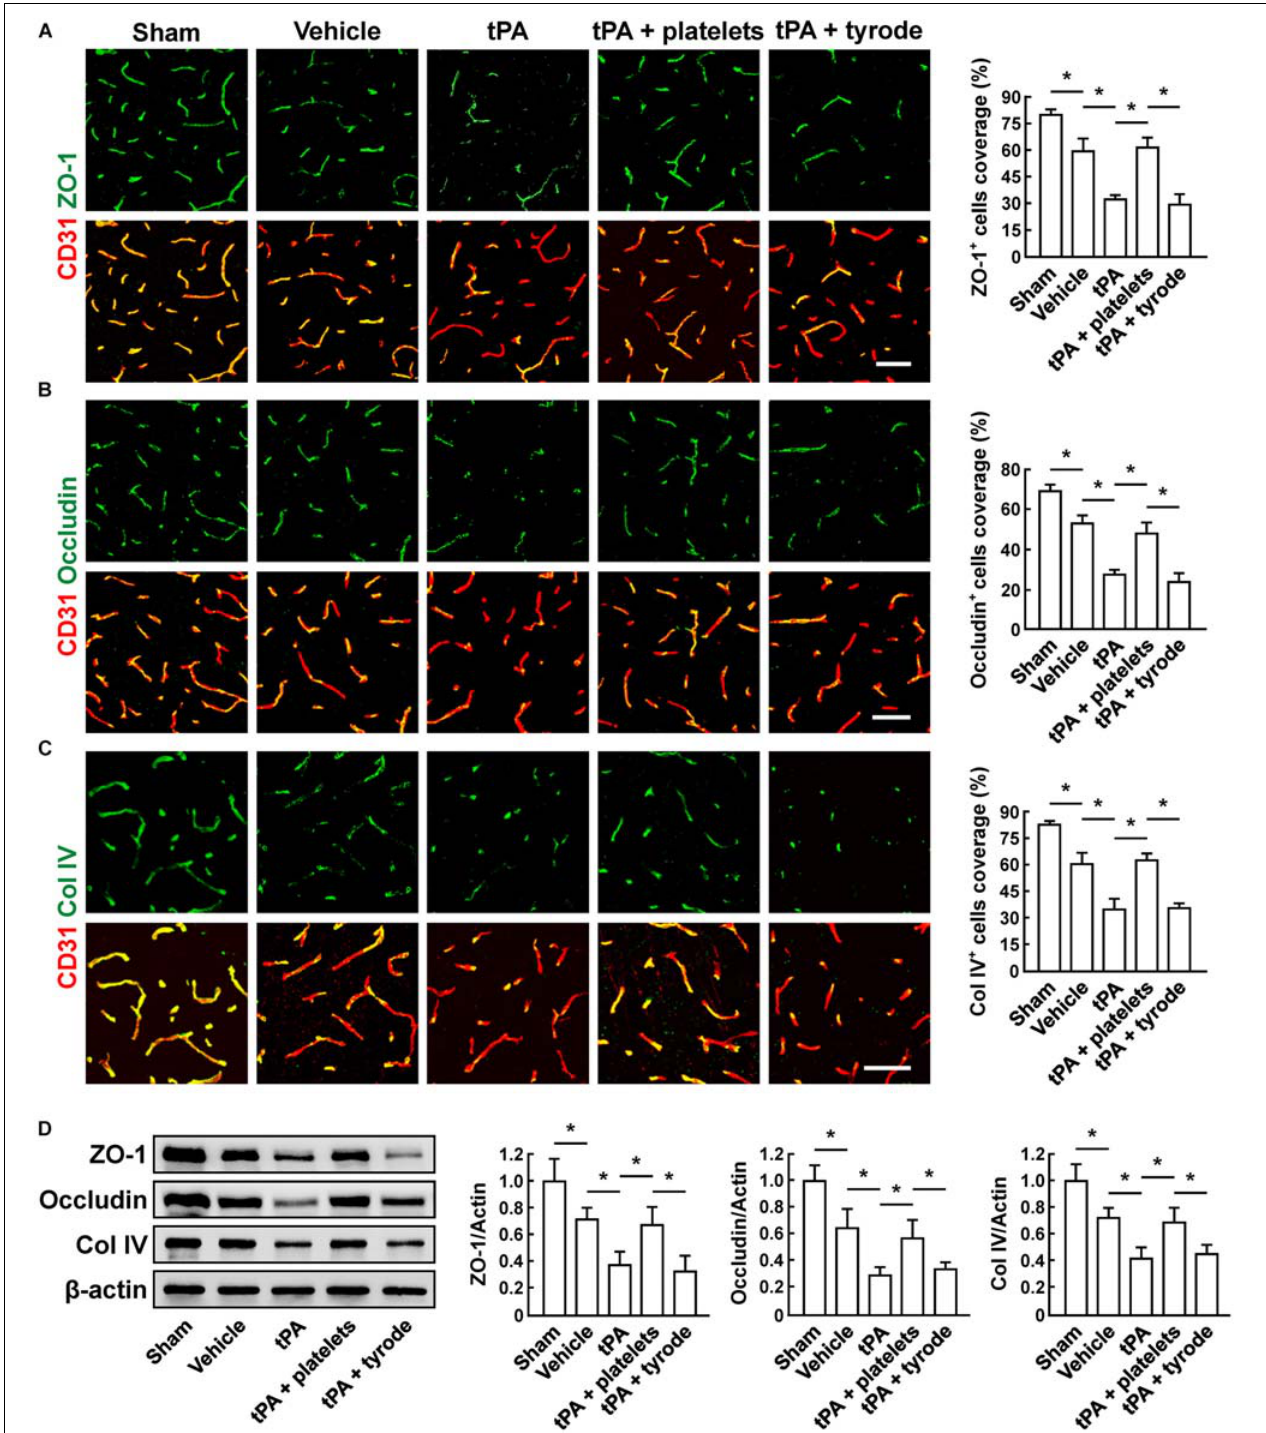
FIGURE 3 | Transfusion of resting platelets ameliorated tPA-induced loss of cerebrovascular integrity after cerebral ischemia. (A–C) Representative images and quantification of tight junction protein zonula occludens (ZO-1) (A) , occludin (B) , and basal membrane protein collagen IV (Col IV) (C) coverage on CD31+ microvessels in sham-operated mice and mice treated with vehicle, tPA, tPA + resting platelets, or tPA + tyrode buffer 24 h after cerebral ischemia. Bar = 60 µ m. n = 5 per group. (D) Representative immunoblots and quantification of ZO-1, occludin, and collagen IV in the brain extracts from sham-operated mice and mice treated with vehicle, tPA, tPA + resting platelets, or tPA + tyrode buffer after cerebral ischemia. n = 5 per group. Values are mean ± SD. ∗ P < 0.05.